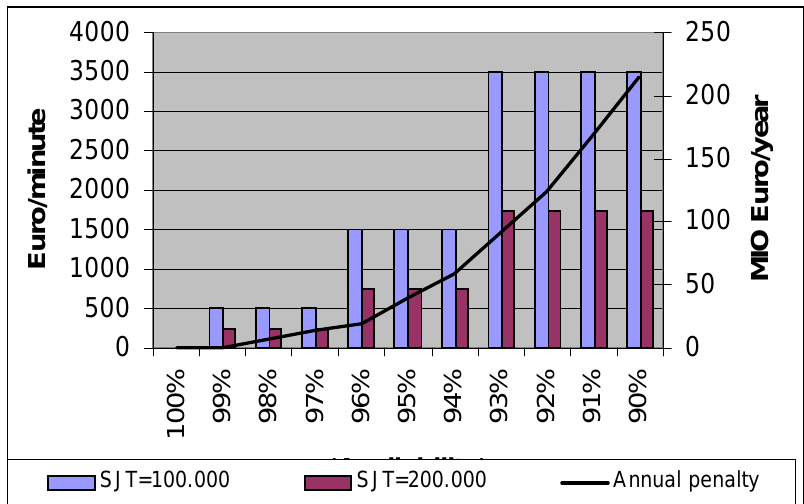
Figure 8. INDICATIVE performance penalties for an annual flat availability level The bars indicate the penalty rate per minute for a given scheduled journey time during four weeks (SJT). The curve indicates the resulting total penalty per year An important finding was the high sensitivity of the outcomes for different availability levels of the system. If in a specified performance period the train delay minutes increase, the penalty rates increase as well, which causes a progressive trend (see Figure 8). This made it also necessary to simultaneously get insight into the influence of the signalling and power supply systems on the total system availability 4